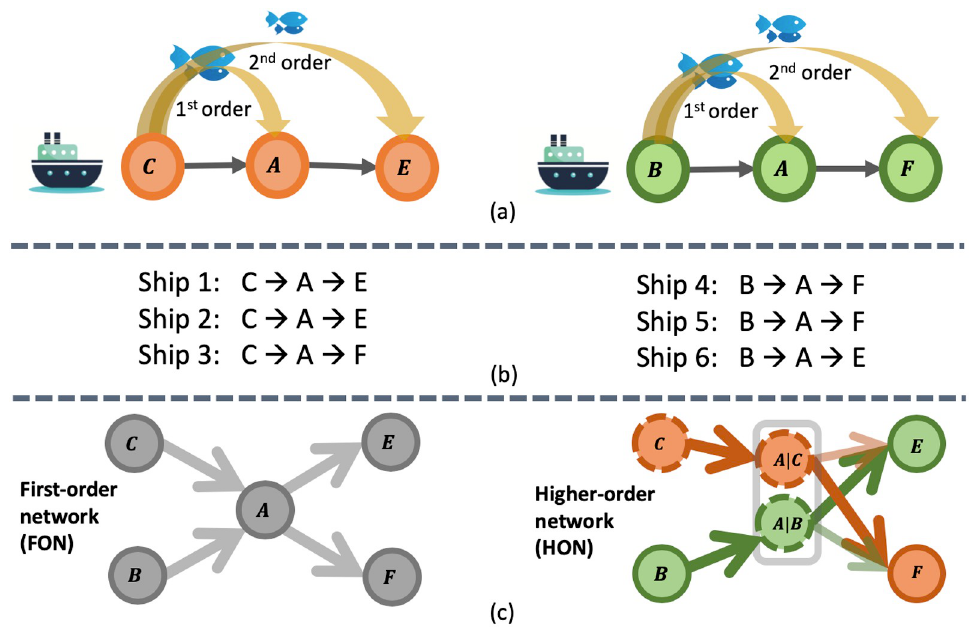
Fig 1. Two different patterns of higher-order species transfer between ports. (b) Out of six ships, ship 1 and 2 follow the pattern in (a) left, and ship 4 and 5 follow the pattern in (a) right. Conventional first-order network ((c) left), where organisms have the same probability of being introduced to port E and F via port A . Higher-order network ((c) right) with a second-order dependency example in species transfer. Due to higher-order patterns in ship movements, organisms native to port C are more likely to get transferred to port F via ships traveling through port A and organisms native to port B are more likely to get transferred to port E via ships traveling through port A .